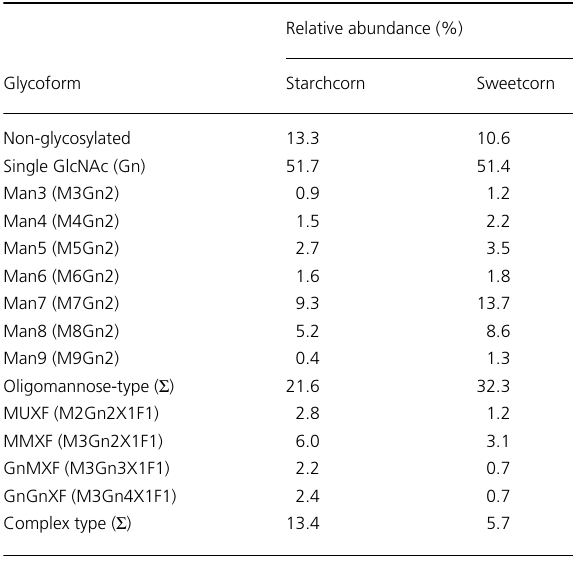
Table 1 Mass spectrometric analysis of the glycopeptides Table 2 Virus neutralization of maize-derived 2G12